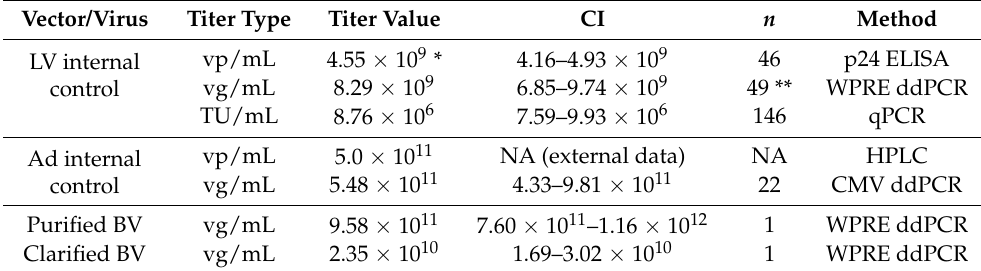
Table 1. The control viruses used in the study.